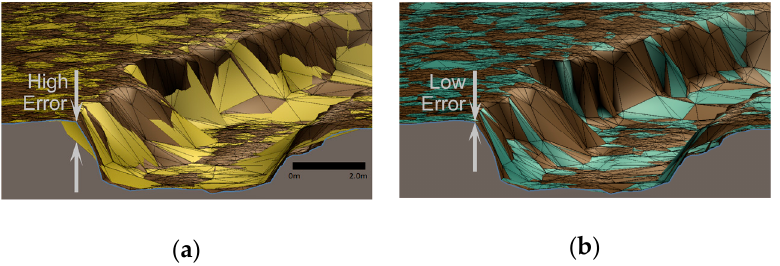
Figure 9. Oblique-perspective view of a portion of the Tuttle Lidar TIN model. (a): overlay of the pre-decimation TIN model (brown) with the random (15% decimation) TIN model (yellow), illustrating how Random Decimation tends to skip location of high curvature, thus introducing higher error (indicated by arrows). (b): overlay of the pre-decimation TIN model (brown) with curvature weighted (15% decimation) TIN model (blue) illustrating how closely CWD matches the undecimated model at high curvature locations.